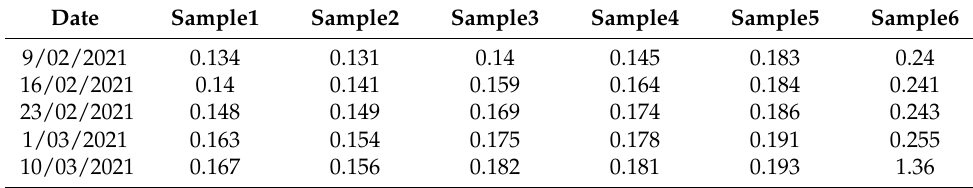
Table A4. Lab NOx data (mg-N L − 1 ).